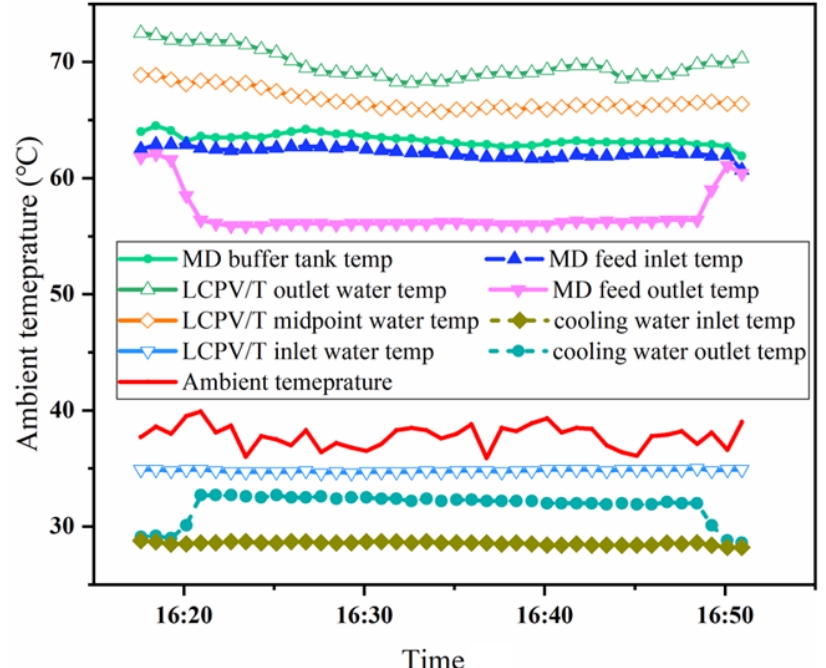
Figure 3. Temperature Variation of single experiment of LCPV/T-VMD system (30 min, 31 July).